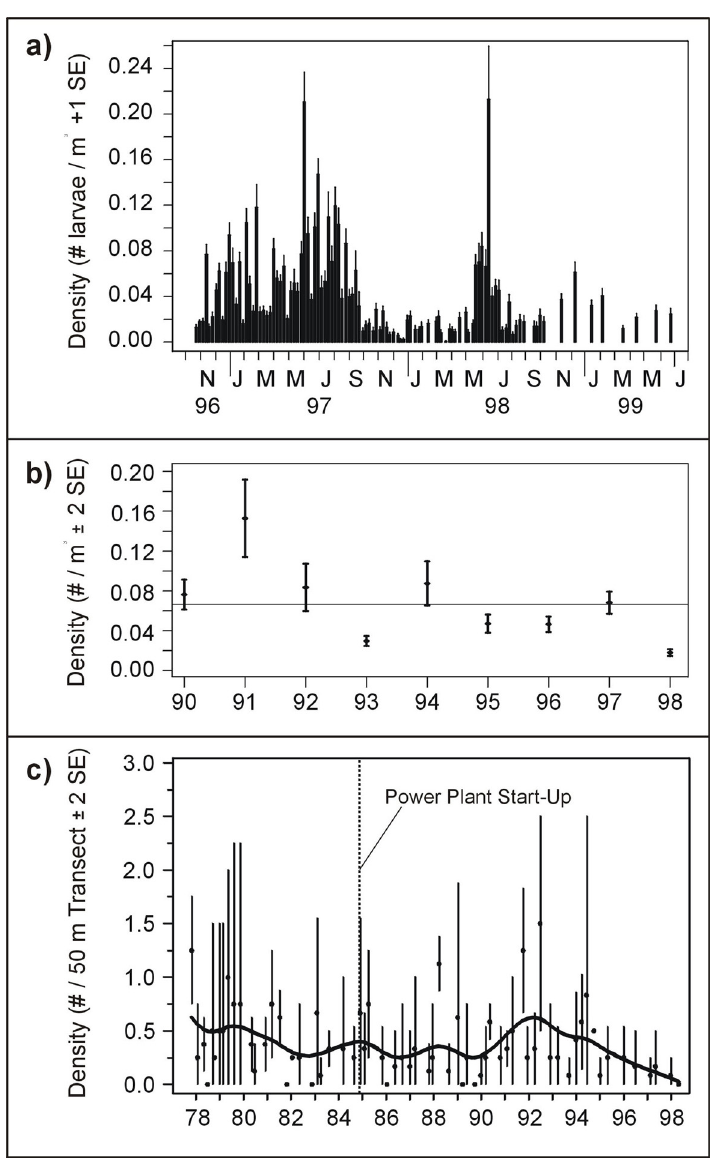
FIGURE 5. (a) Weekly mean density of larval kelpfish (#/m 3 + 1SE) at the DCPP intake. (b) Annual mean density ± 2 SE of larval kelpfish (vertical lines) and grand mean density for all years combined (horizontal line) for the intake cove surface plankton tows. (c) Mean density of kelpfish (#/50 m transect ± 2 SE) estimated from SCUBA surveys in an area 700 m south of the DCPP intake cove. Spline smoothing algorithm used to draw the curve through the